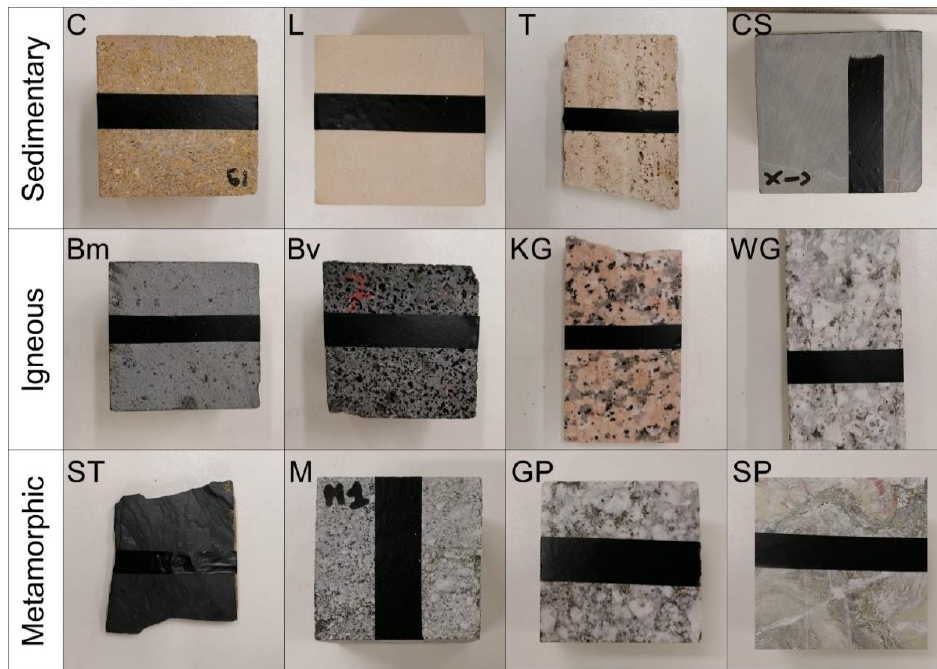
Figure 2. Some representative specimens belonging to the different rock categories tested herein.